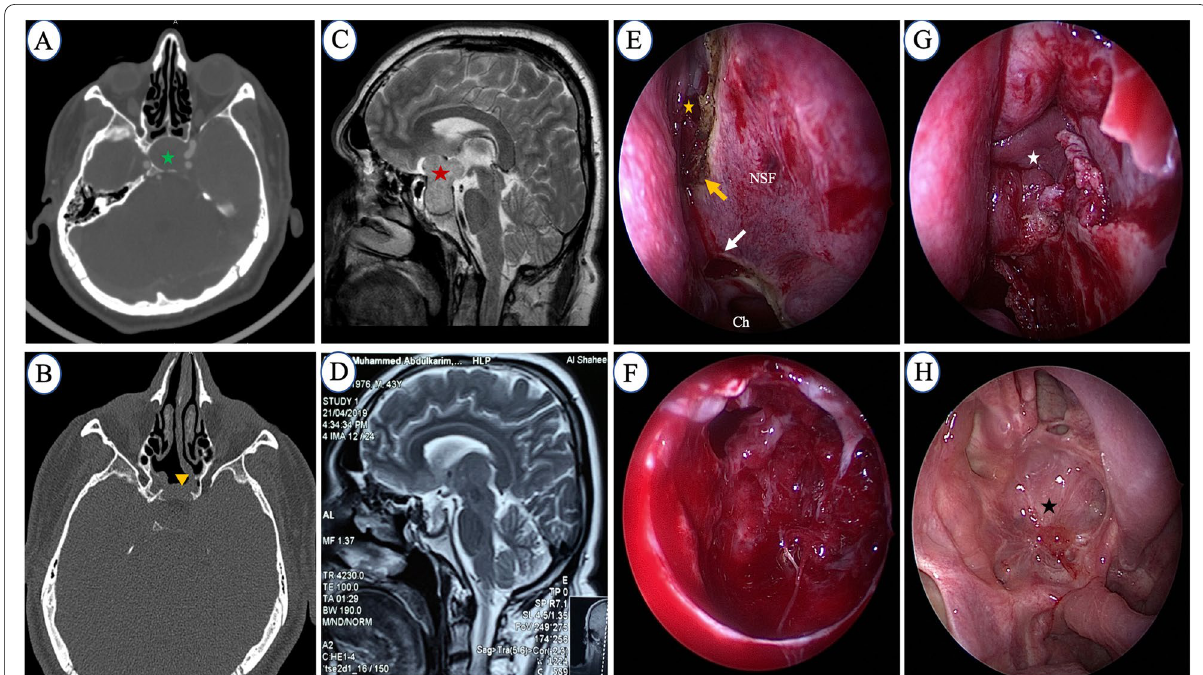
Fig. 3 Transnasal paraseptal transsphenoidal hypophysectomy with skull base reconstruction by multilayer technique using (fascia lata graft and NSF). A CT scan image (axial view) showing the isodense opacity filling the sphenoid sinus bilaterally marked with green asterisk. B Six months postoperative CT scan (axial view) showing resected pathology with reconstructed skull base defect which denoted with yellow arrowhead. C T2-weighted MRI (sagittal view) showing a large pathology filling the sella with a suprasellar extension denoted by red asterisk. D Six months postoperative T2-weighted MRI (sagittal view) shows resected pathology with reconstructed skull base. E Nasoseptal flap (NSF) pedicle with superior incision marked by yellow arrow and inferior incision marked with white arrow, sphenoidotomy denoted by yellow asterisk. F Endoscopic image showing the sellar and suprasellar areas free of the tumor. G Harvested NSF draped as third outer layer in the reconstruction. H Six months postoperative endoscopic image showing posterior part of the nasal cavity illustrating posterior septectomy, reconstructed skull base defect with NSF showing complete mucosalization which denoted with a black